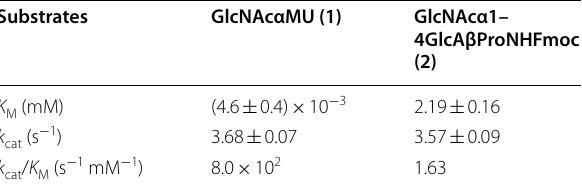
Table 4 Apparent kinetic parameters of ∆22Bt3590 Substrates